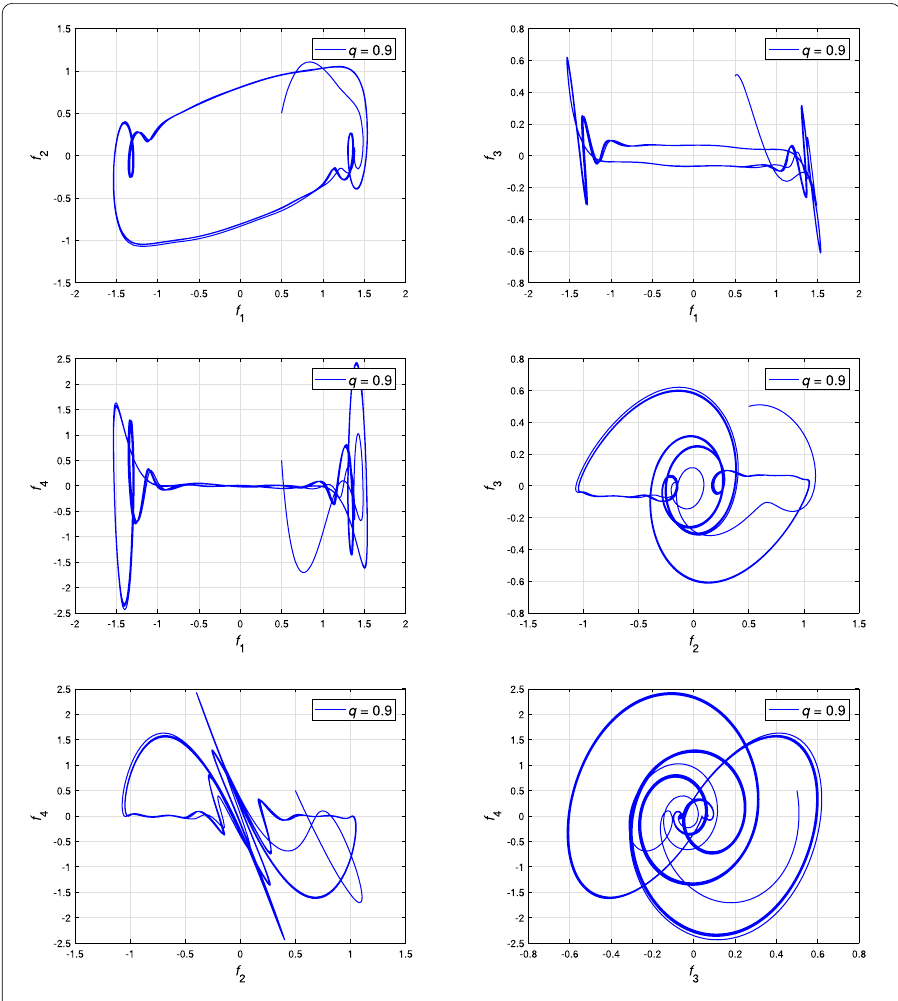
Figure 1 The phase planes of the fractional chaotic system (6) for q =